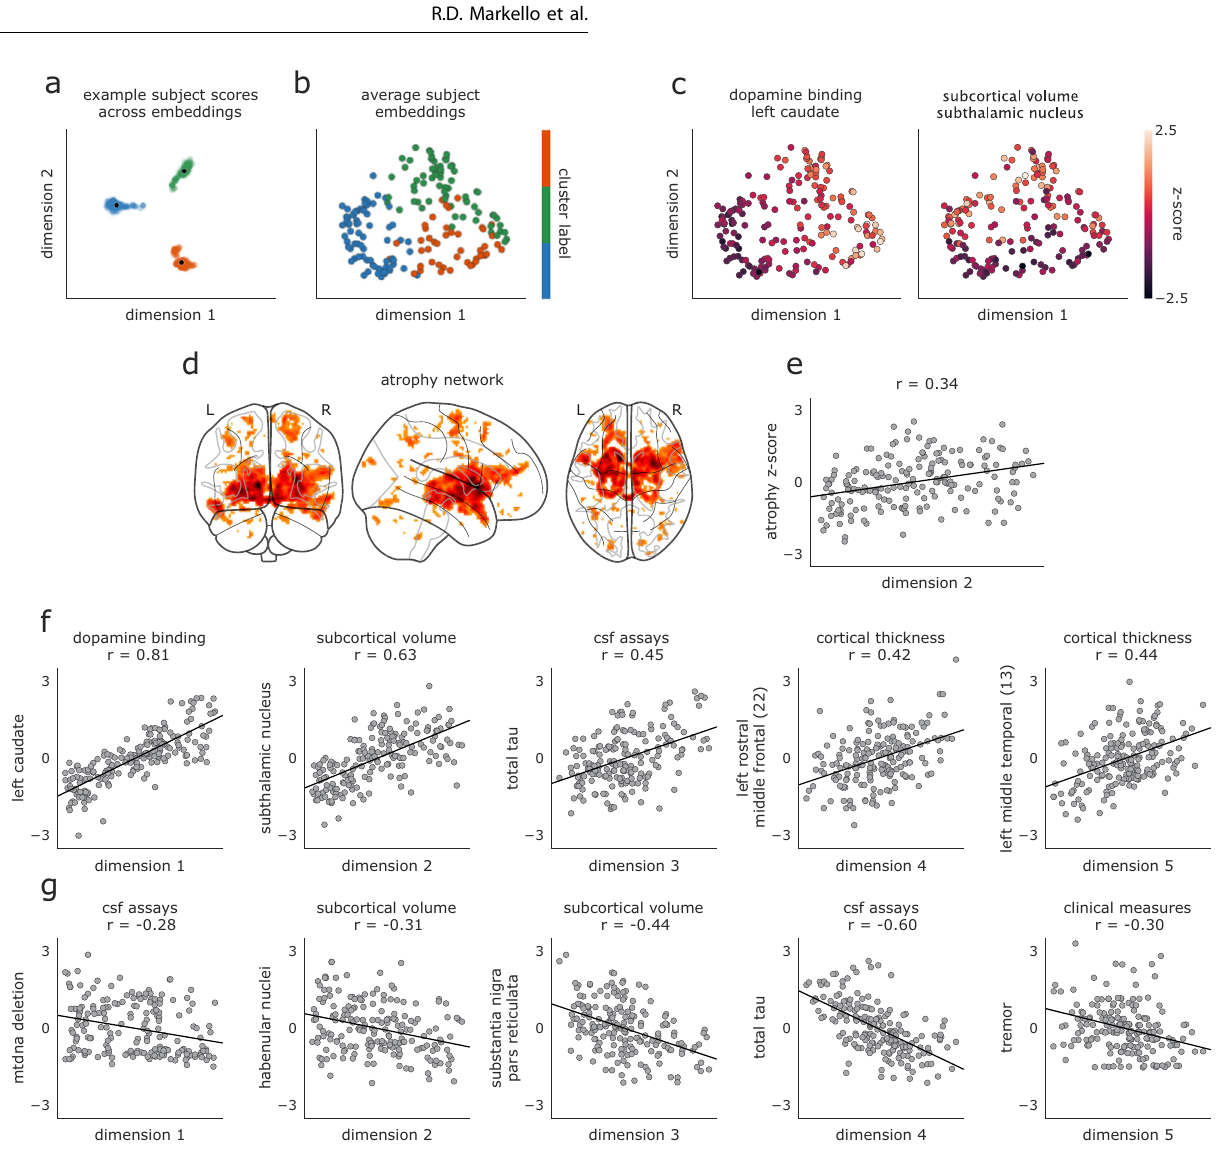
linear regression was performed using the fi rst fi ve embedding dimensions as predictors of each clinical score; betas were estimated from 80% of the data and applied to predict scores for the remaining 20%. Out-of-sample scores were predicted moder- ately well (average Pearson correlation between real and predicted scores: r tremor = 0.20 [SD = 0.22] ; r pigd = 0.22 [SD = 0.22]).